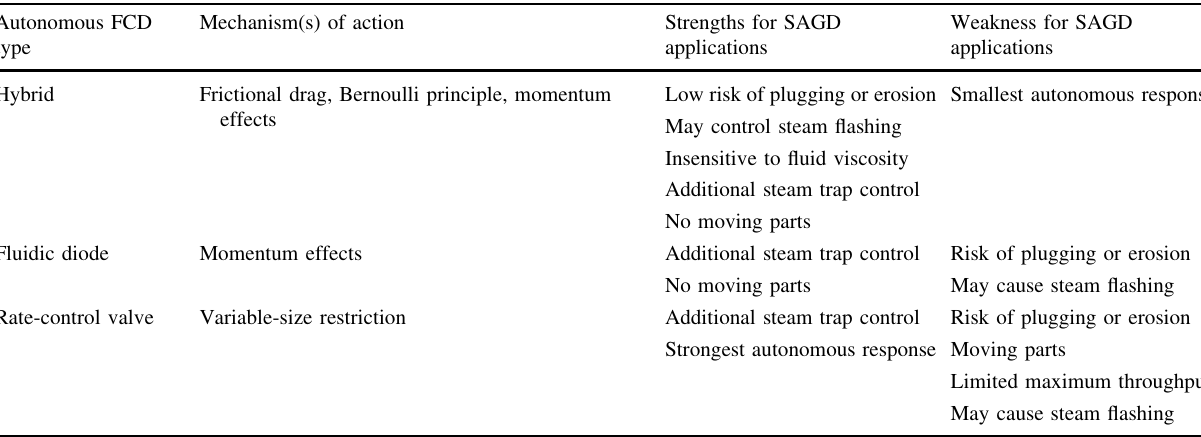
Table 2 Comparison of commercially available autonomous